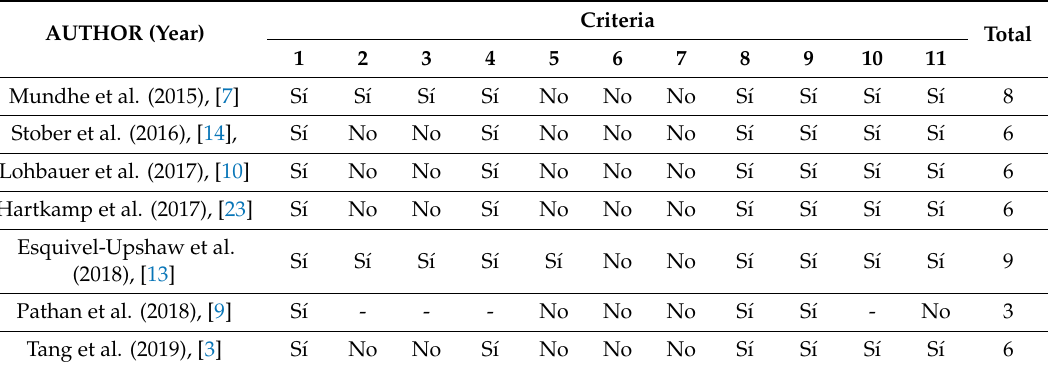
Table 2. Quality of the studies according to PEDro scale for clinical